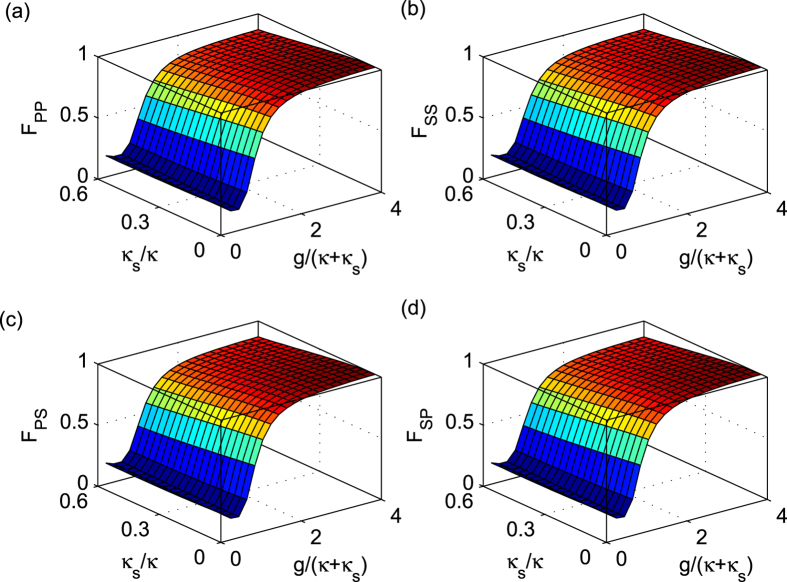
Average fidelities of the present photon switches.(a) The average fidelity FPP of the polarization DOF switch on a two-photon system. (b) The average fidelity FSS of the spatial DOF switch on a two-photon system. (c) The average fidelity FSP of the photon cross switch on a two-photon system. (d) The average fidelity FPS of the photon cross switch on a two-photon system. The coupling strength is defined by ς = 0.1κs. The average fidelity is computed as the expectation of input photons. Here,  from the equation (2) and rh = 1 − [(1 + 3.64g2/(κ + κs)2)2 + (1 + κs/κ + 0.364g2/(κ + κs)2)2]−1/2 from the equation (1).